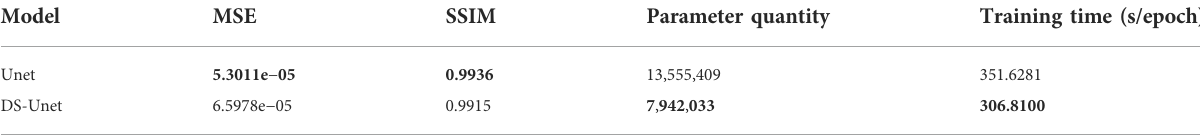
TABLE 2 Comparison of two networks on fi eld data (the bold font indicates the best value).